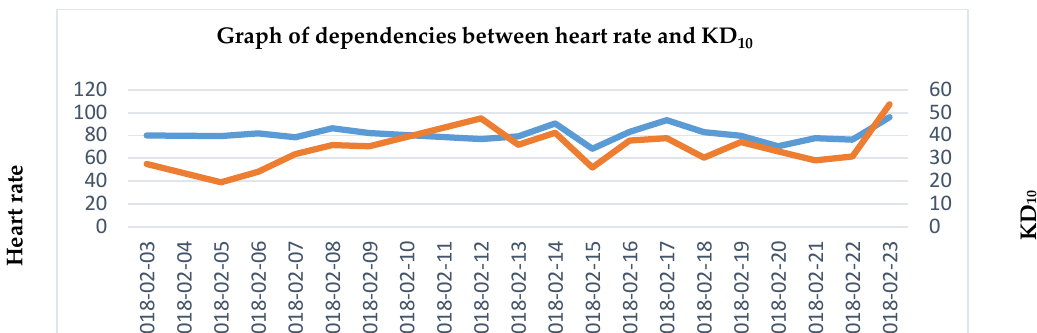
Heart Rate KD10